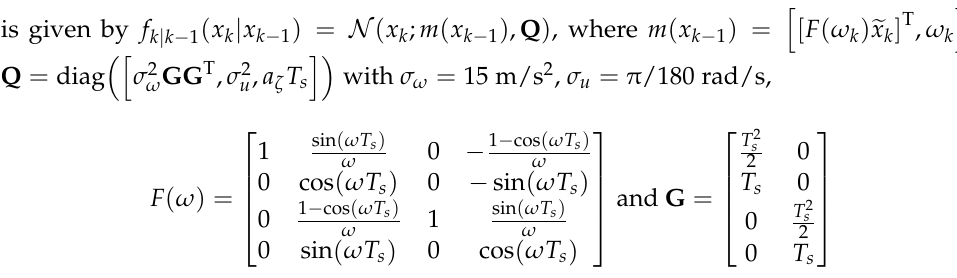
Figure 5. The estimated track of multiple targets for a single MC run. The colored dots represent the estimated position. In a radar TBD scenario under the non-separable likelihood assumption, the clutter measurements are uniformly distributed on the observation space and is a Poisson RFS with